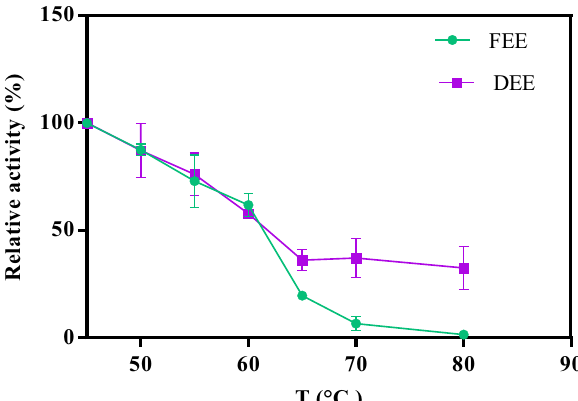
Figure 7. Thermal stability of the peroxidase as the dried extracted enzyme (DEE) and freshly extracted enzyme (FEE).